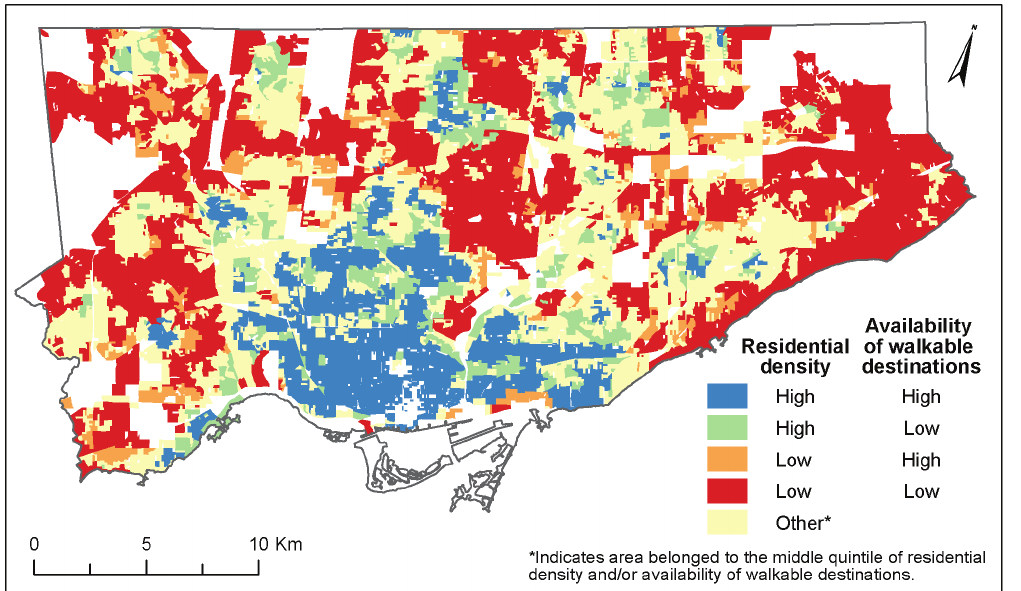
Figure 1. Spatial Concordance Between Residential Density and Availability of Walkable Destinations. Data from: the 2006 Canada Census; DMTI Spatial Inc., 2009; the City of Toronto, 2009; and the Ministry of Education, 2009. Residential density was calculated as the number of residential dwellings per square kilometer in all census disseminations blocks (DB) intersecting an 800 m buffer of a given DB’s residentially-weighted centroid. Availability of walkable destinations was calculated as the number of retail and service destinations, including public recreation centers and schools, within an 800 m buffer of a given DB’s residentially-weighted centroid. A DB was labeled ‘high’ for residential density or availability of walkable destinations if its value for that attribute placed it within the highest 2 quintiles for that attribute; similarly a DB was labeled as ‘low’ if its value placed it within the lowest 2 quintiles for that attribute.